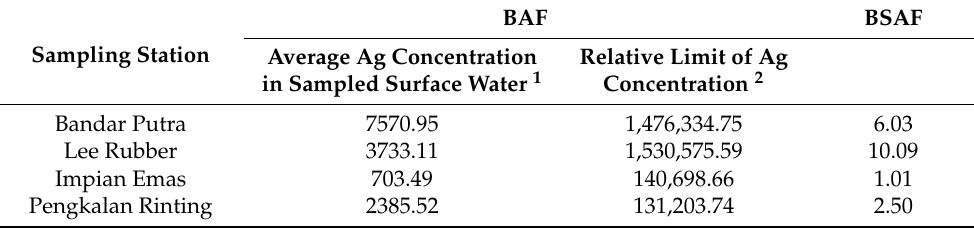
Table 4. List of BAF and BSAF values for each sampling